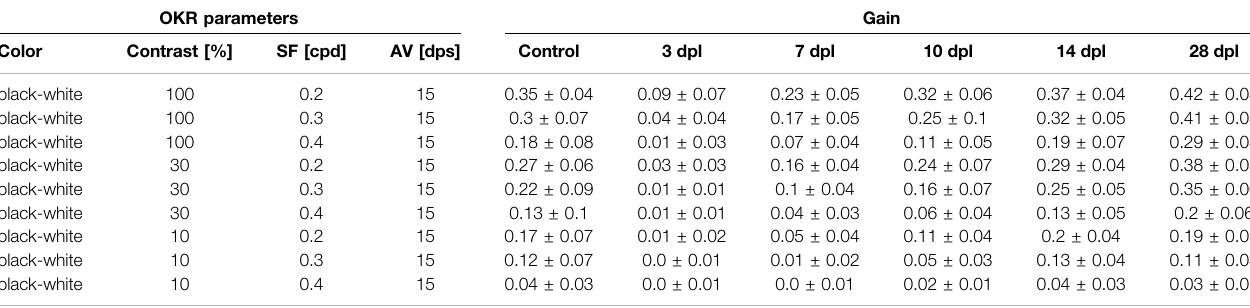
TABLE 1 | Individual data points for the fi rst level of the OKR-based vision test in the course of regeneration. OKR